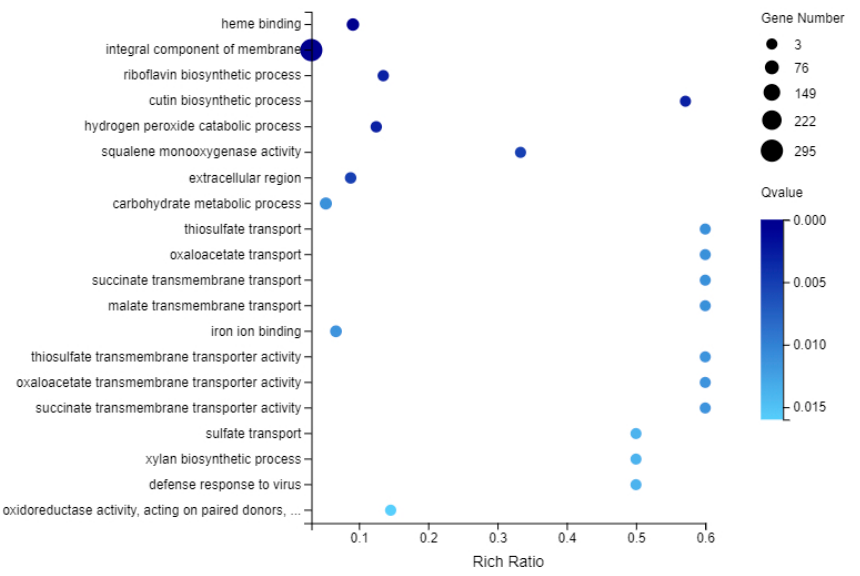
Figure 8. GO enrichment of